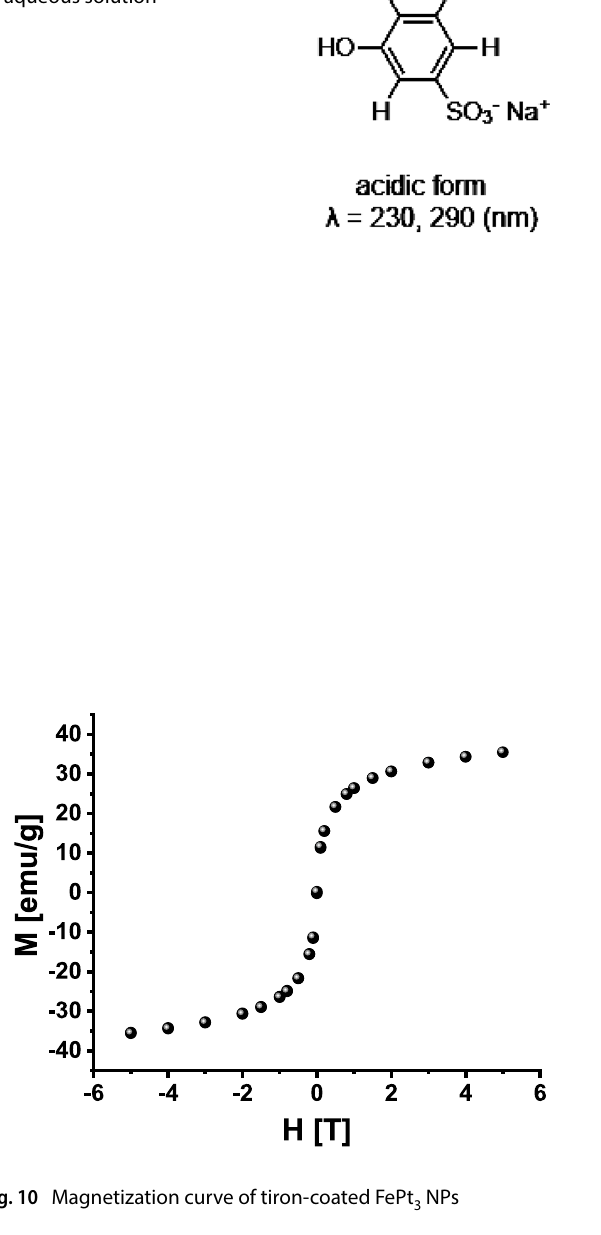
Fig. 9 pH dependency of tiron in aqueous solution